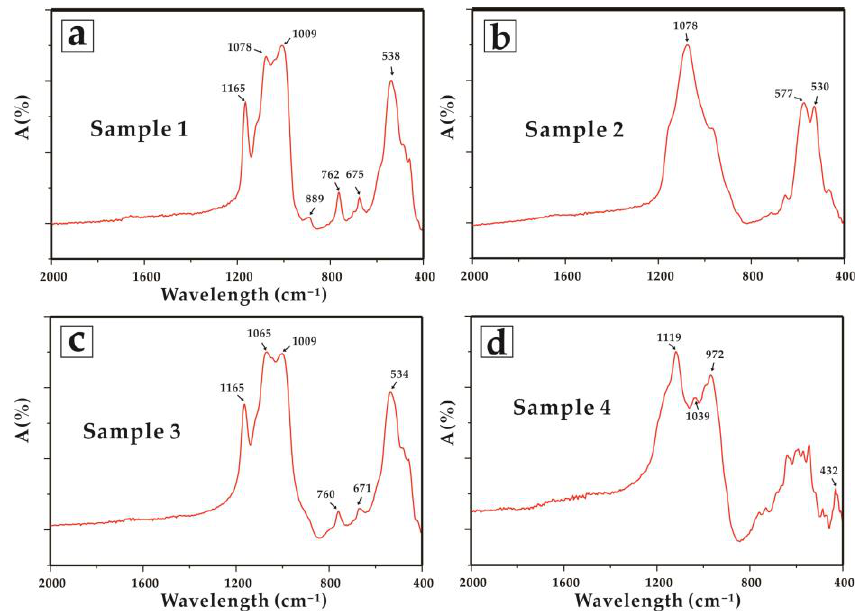
Figure 2. Infrared spectra after K – K transformation: ( a ) Sample 1; ( b ) Sample 2; ( c ) Sample 3; ( d ) Sample 4.